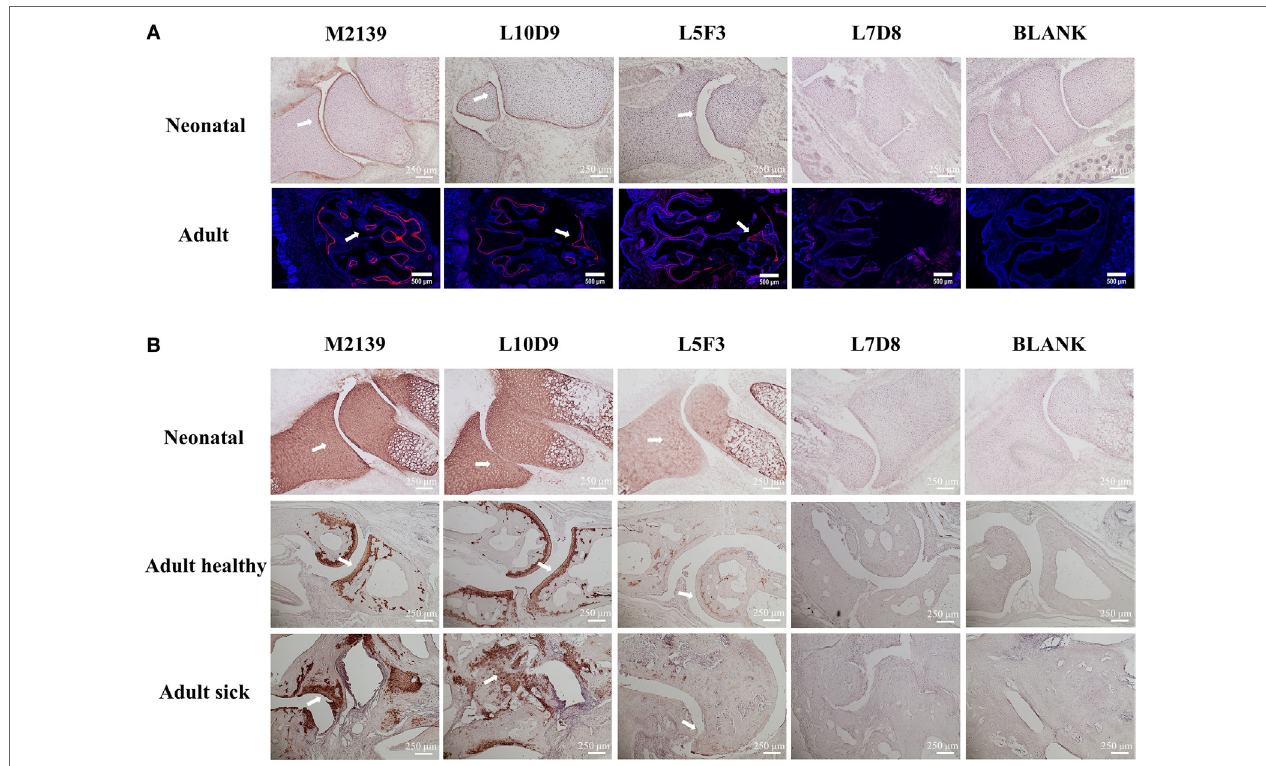
FigUre 4 | L10D9 binds to cartilage both in vivo and in vitro . In vivo (a) and in vitro (B) histology staining of joint or transversal snout sections are shown. Positive binding to cartilage surfaces are marked by